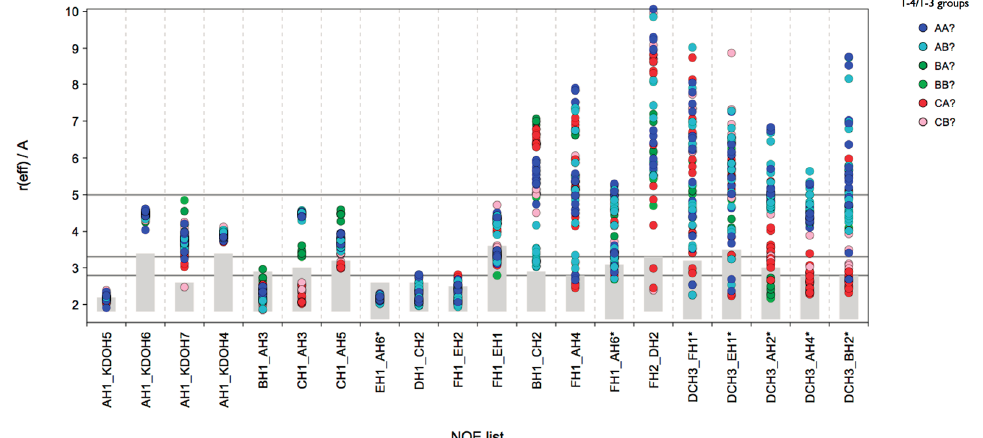
Figure 6. lgt2 Δ OS: CAT analysis of r eff for conformational sub-ensembles (state groups). Combined states of all glycosidic linkages except the (1-5)-linkage to Kdo are used. The horizontal lines indicate the distance limits for classification into strong ( ≤ 2.8 Å), medium ( ≤ 3.3 Å) and weak ( ≤ 5.0 Å) NOEs. The grey boxes indicate the range [ r vdW , r NOE ]. The color code separates sub-ensemble types defined by the (1-4)- and (1-3)-linkages: “AB?” means the (1-4)-linkage is in minimum A and the (1-3)-linkage is in minimum B; the states of the other linkages are not considered for color coding indicated by the “?”. “AB?” could therefore be state groups ABAAA, ABABB, ABBAA, etc. The composite “virtual distances” are marked with an asterisk